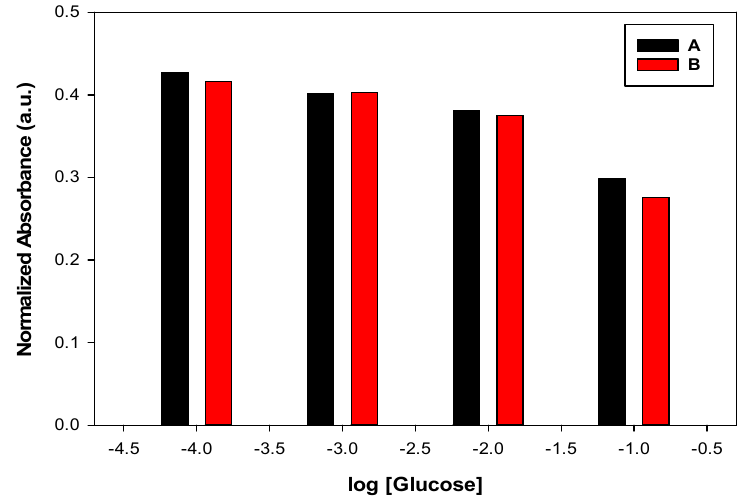
Figure 7. Reproducibility of the two optodes (A, B) prepared from the same composition of optode 3 in response to different glucose solutions (10 − 4 M, 10 − 3 M, 10 − 2 M, and 10 − 1 M).